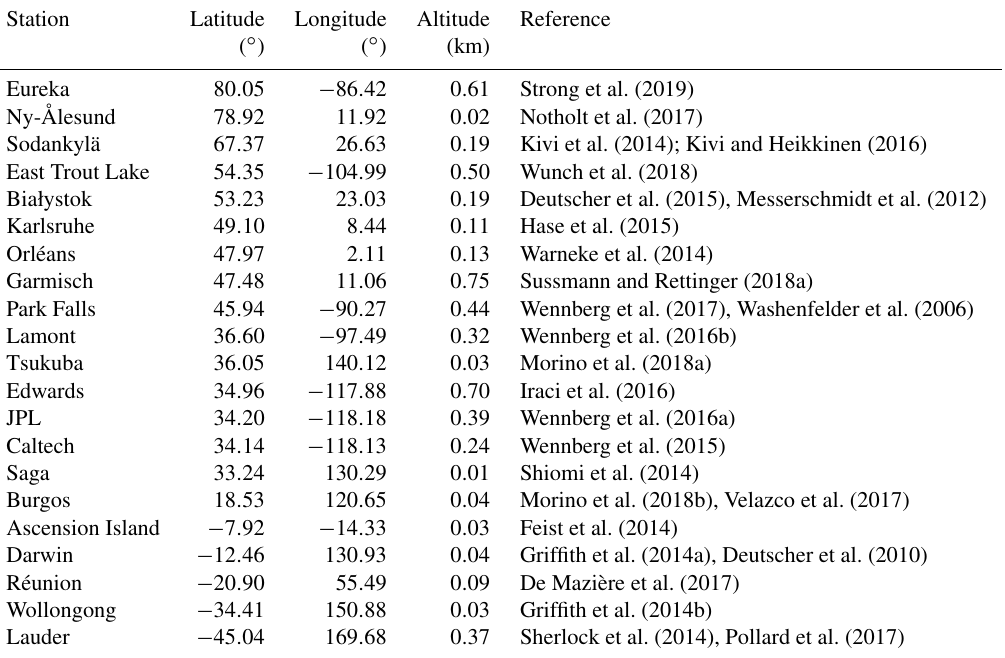
Table 3. TCCON sites used in the validation ordered according to latitude from north to south. Station Latitude